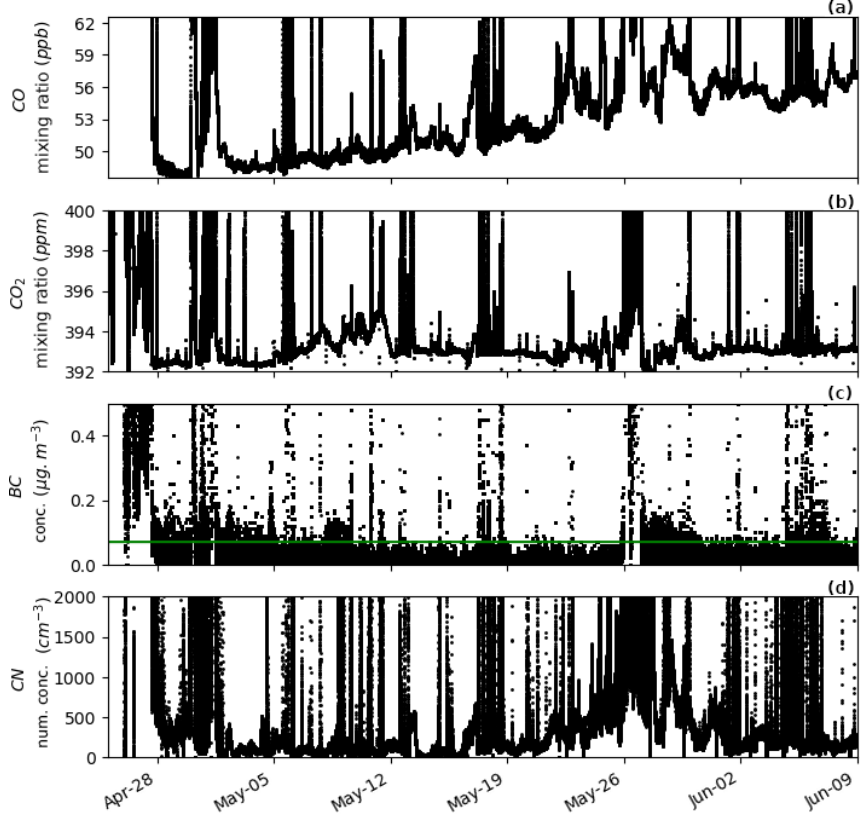
Figure A3. As in Fig. A2 but with a linear y scale to reveal the baseline